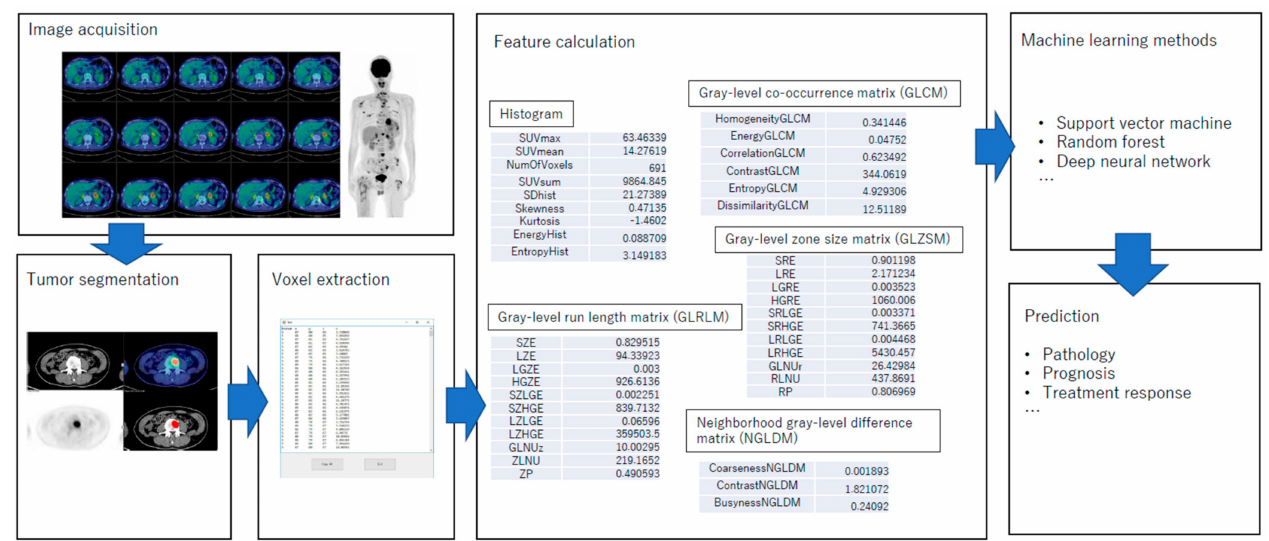
Figure 1. Radiomics showing how to perform tumour segmentation, voxel extraction from actual FDG PET images in order to assess feature calculation with various parameters using machine learning methods. These radiomic parameters will be applied for predictions of pathology, prognosis, and treatment